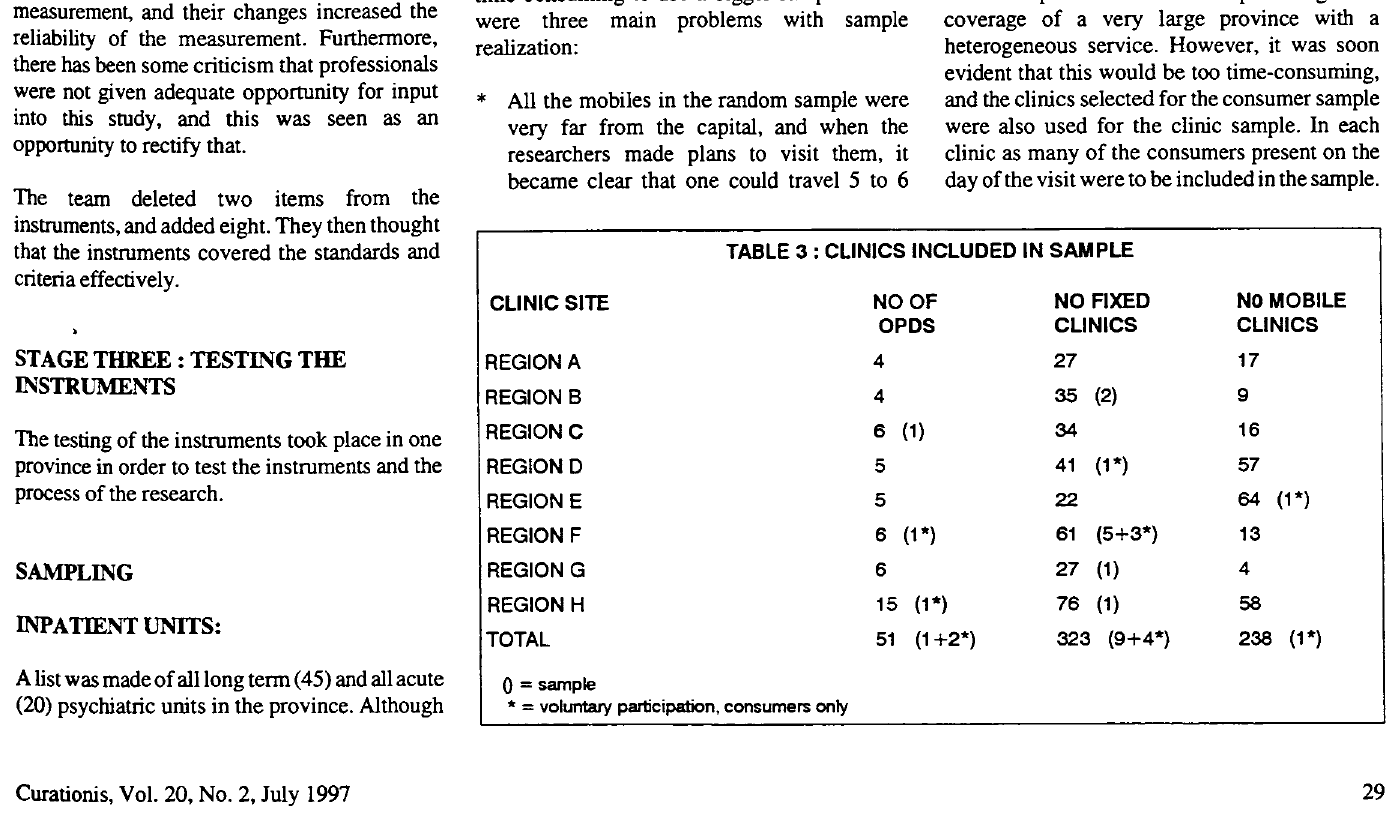
TABLE 3 : CLINICS INCLUDED IN